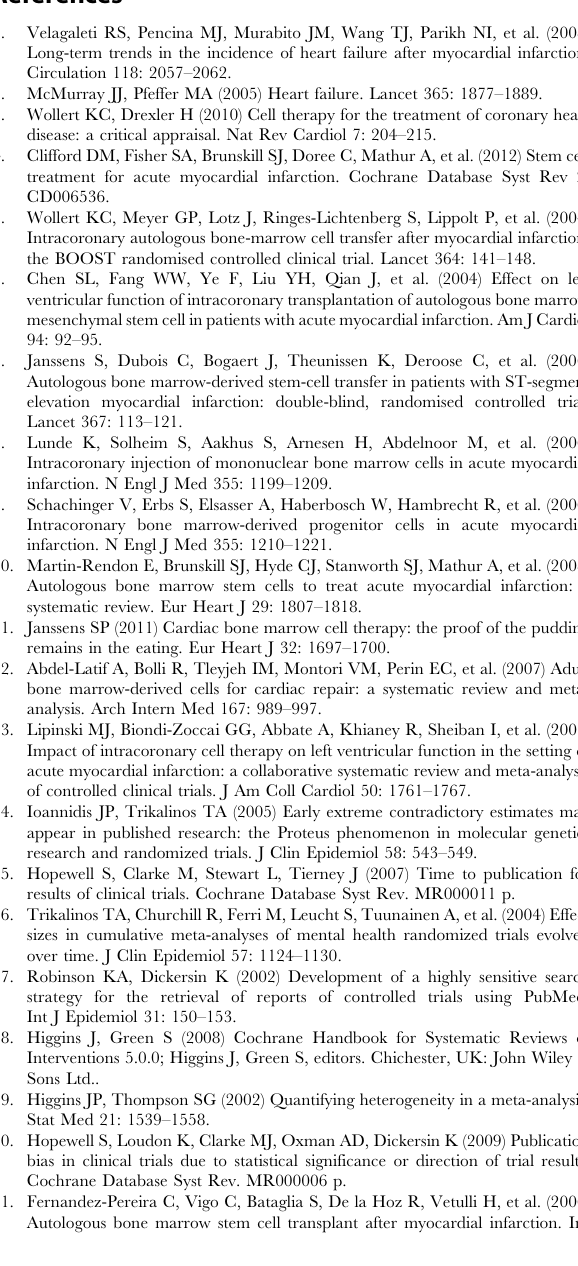
Figure S1 PRISMA diagram. Table S1 Characteristics of the included studies. (DOC) Table S2 Relative risk of dichotomous clinical out- comes. Table S3 Weighted mean differences of continuous outcomes measured. Table S4 Quality assessment of included studies.